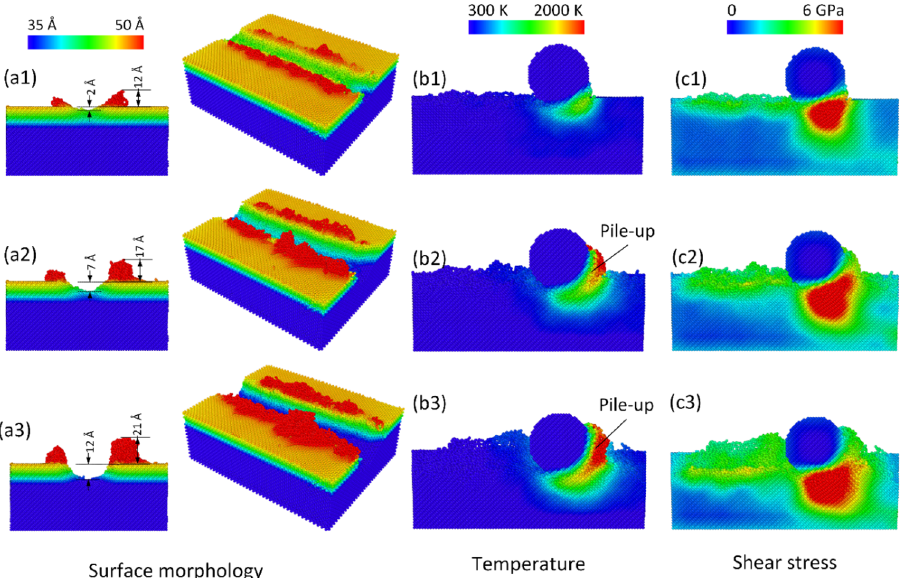
Figure 7. Surface morphology, temperature, and shear stress distributions when applying multi-machining in the vertical direction at 300 K and 100 m/s: ( a1 – c1 ) first time, ( a2 – c2 ) second time, and ( a3 – c3 ) third